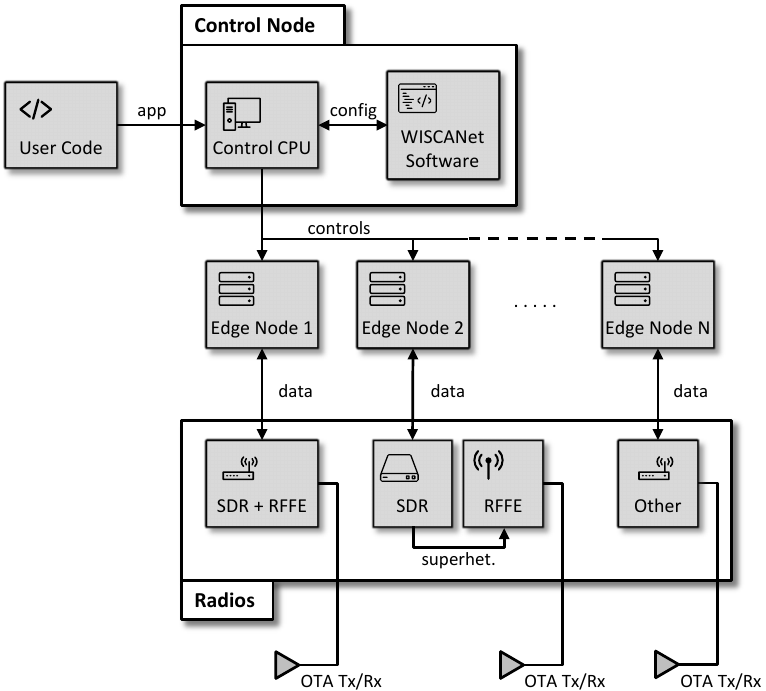
Figure 1. The WISCANet control software runs on a control computer, which receives a user-defined application and automatically configures the connected edge nodes and radio to execute it. This allows users to deploy over-the-air radio applications without programming the radios themselves, which reduces development time and makes experimentation more accessible to